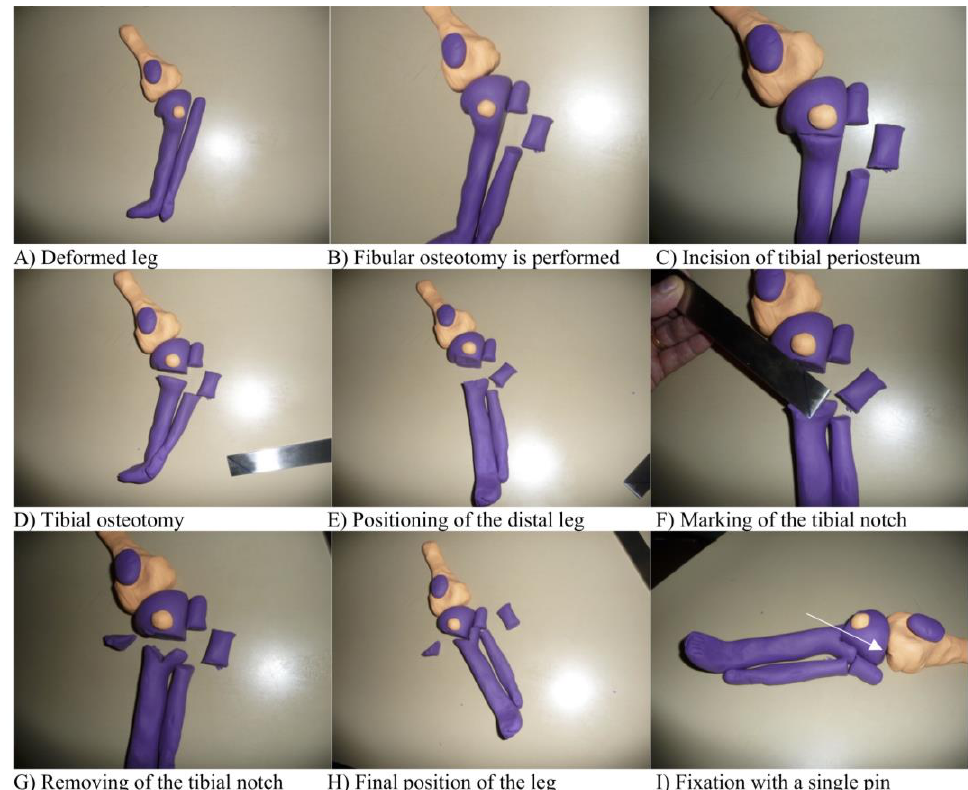
Figure 1. ( A – I ). Model of surgical steps with purple dough representing the tibia and the patella and the light dough representing the femur and the tibial tuberosity.